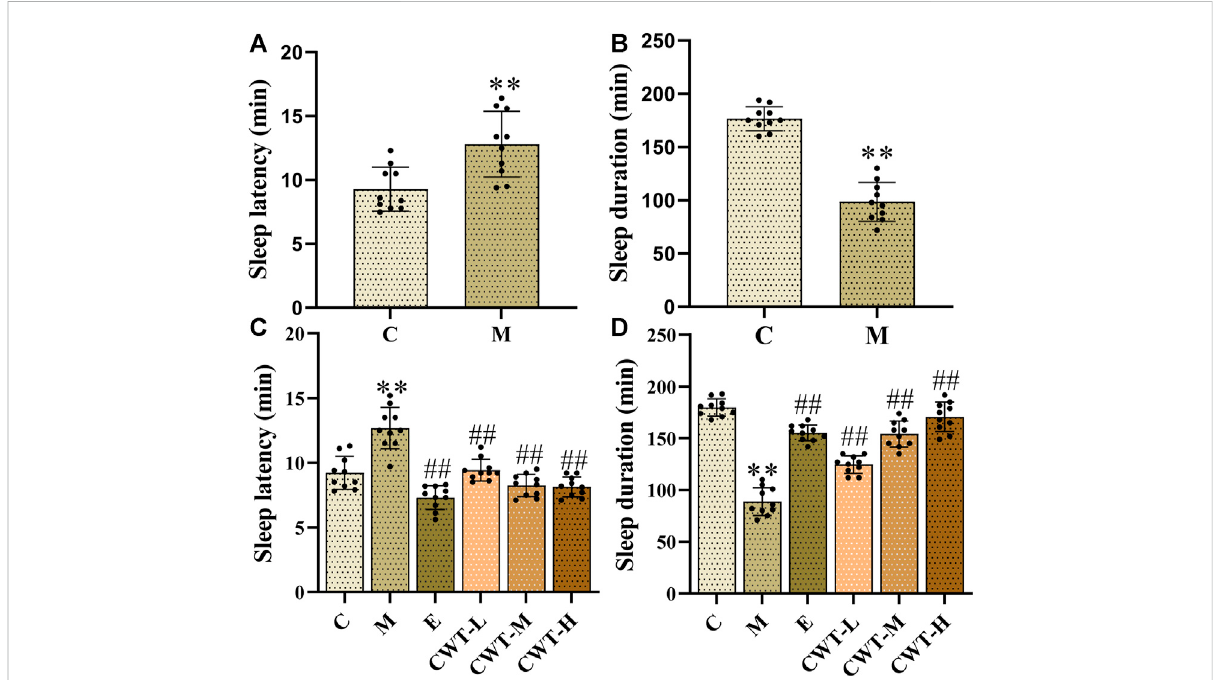
FIGURE 8 Sleep test results (C: control group, n = 10; M: model group, n = 10; E: estazolam group, n = 10; CWT-L group, n = 10; CWT-M group, n = 10; CWT-H group, n = 10; compared with the group C, * p < 0.05, ** p < 0.01; compared with the group M, # p < 0.05, ## p < 0.01, mean ± SD). Figures (A,B) : Test results on the fourth day of insomnia model establishment; Figures (C,D) : Test results on the seventh day of treatment. (A) : Detection of sleep latency of rats in groups C and M. (B) : Detection of sleep duration of rats in groups C and M. (C) : Detection of sleep latency of rats in each group. (D) : Detection of sleep duration of rats in each